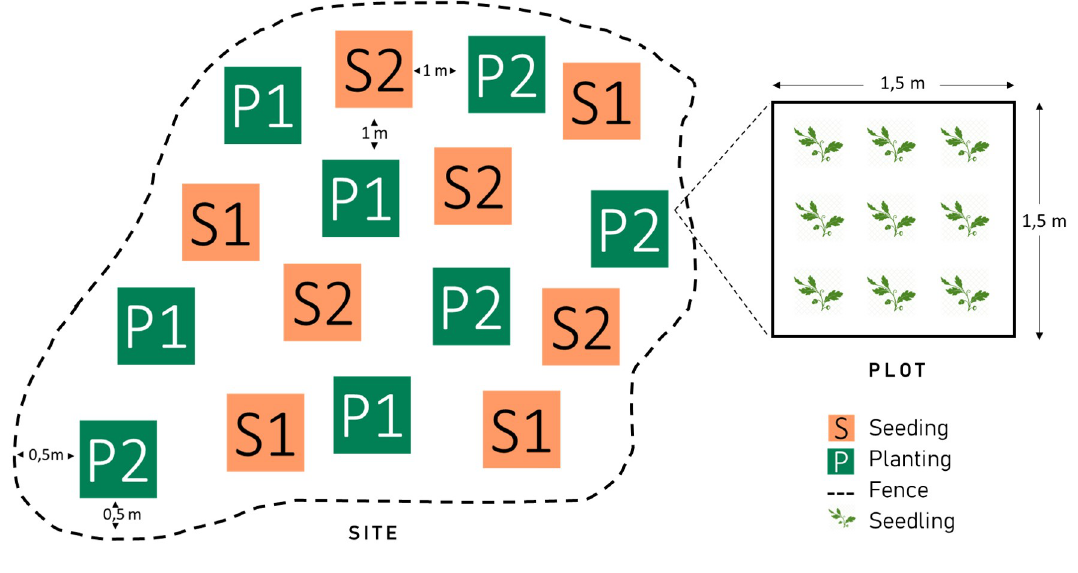
Fig 3. Design of a site of irregular shape and with two species (indicated as 1 and 2). The experimental combinations must be randomly allocated to all plots, thereby ensuring that plots of different species and method are spatially